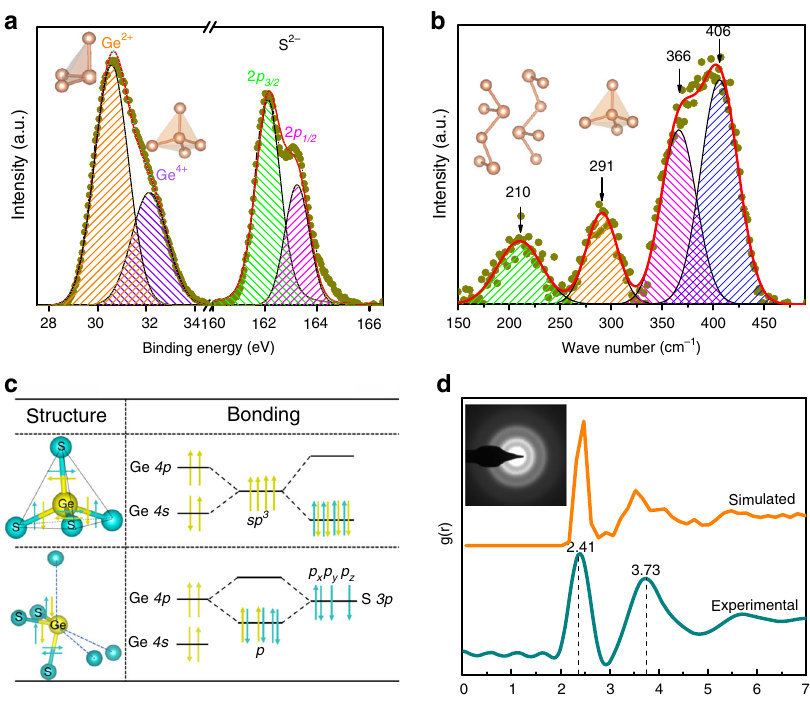
Fig. 5 Local structures of amorphous GeS. a The XPS of Ge 3 d and S 2 p orbitals. b Raman spectrum of GeS fi lm. c Atom con fi guration and bonding environment of pyramidal and tetrahedral Ge-centered structural motifs. d Comparison of the experimental RDF by electron diffraction method and simulated RDF obtained by DFT MD simulation. The inset is the corresponding electron diffraction pattern of amorphous GeS fi